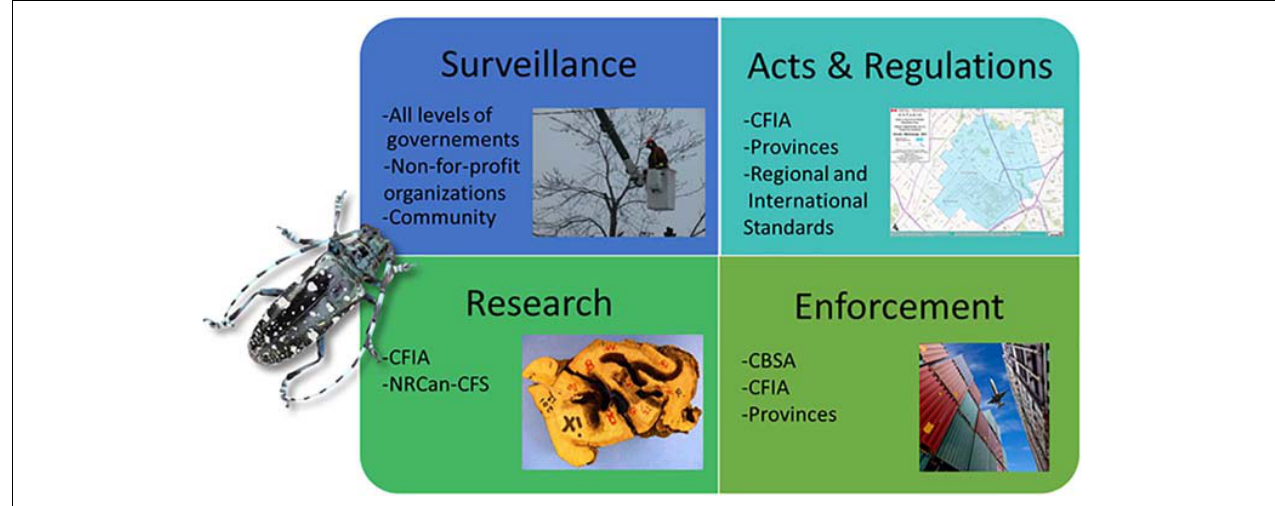
FIGURE 2 | Multi-agency integrated approach to forest biosecurity as illustrated by the Asian longhorned beetle, Anoplophora glabripennis responses in Toronto, Canada. Photos: Asian longhorned beetle, Mike Bohne USDA-FS FHP; the Surveillance, Acts & Regulations, and Enforcement images come from the CFIA and the Research image from the laboratory of Jean Turgeon